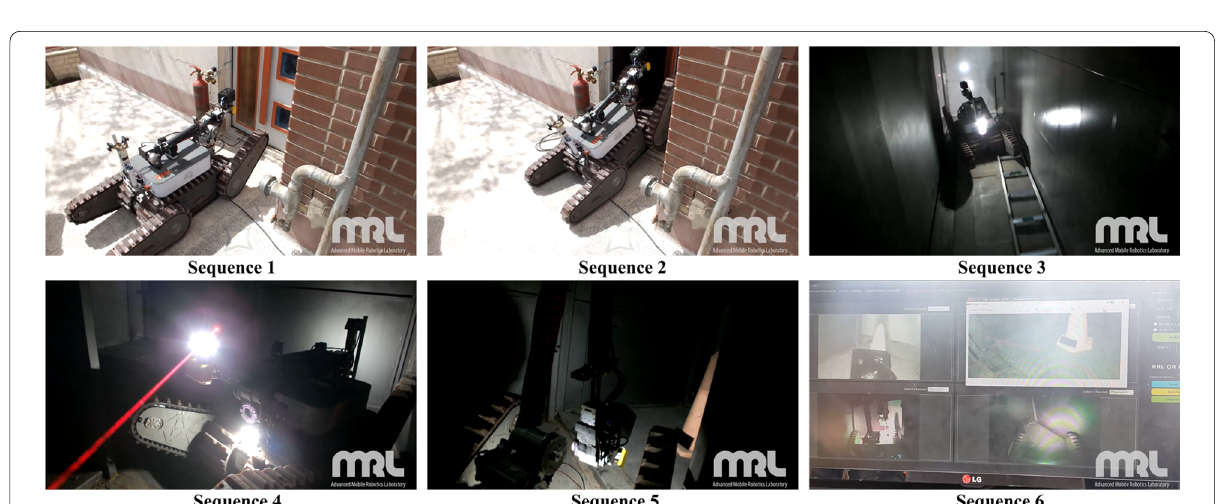
Fig. 29 The inspection of a dark corridor by the